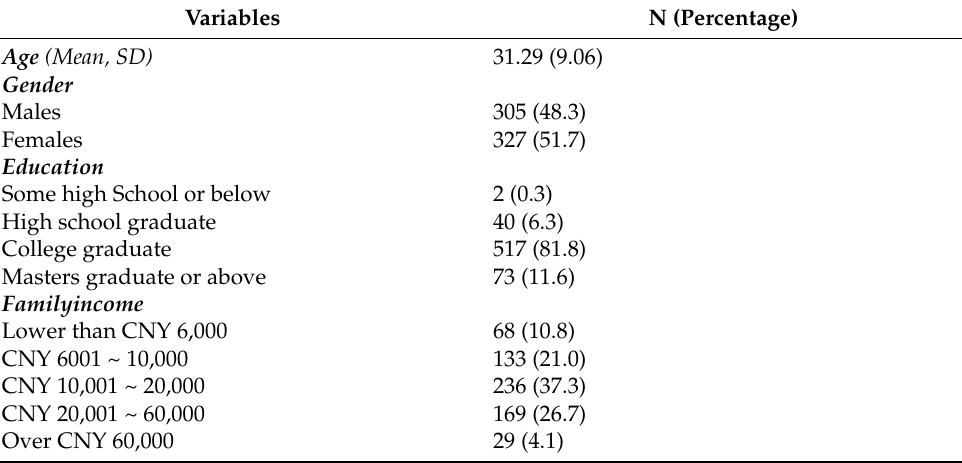
Table 1. Sample characteristics of the present study (N =